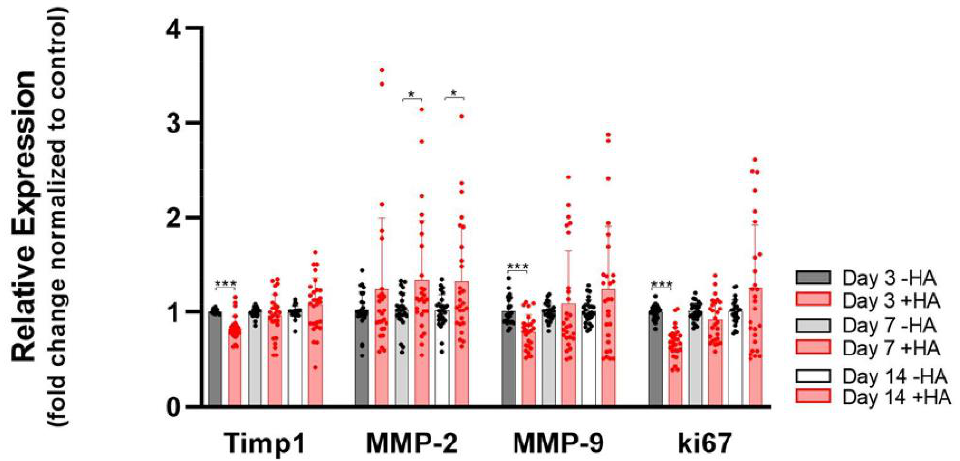
Figure 4. Remodeling markers and proliferation marker ki67 . Stars indicate pairwise comparison probability in Student’s t test , where HA was compared to the control: p < 0.05 (*) and p < 0.001 (***).